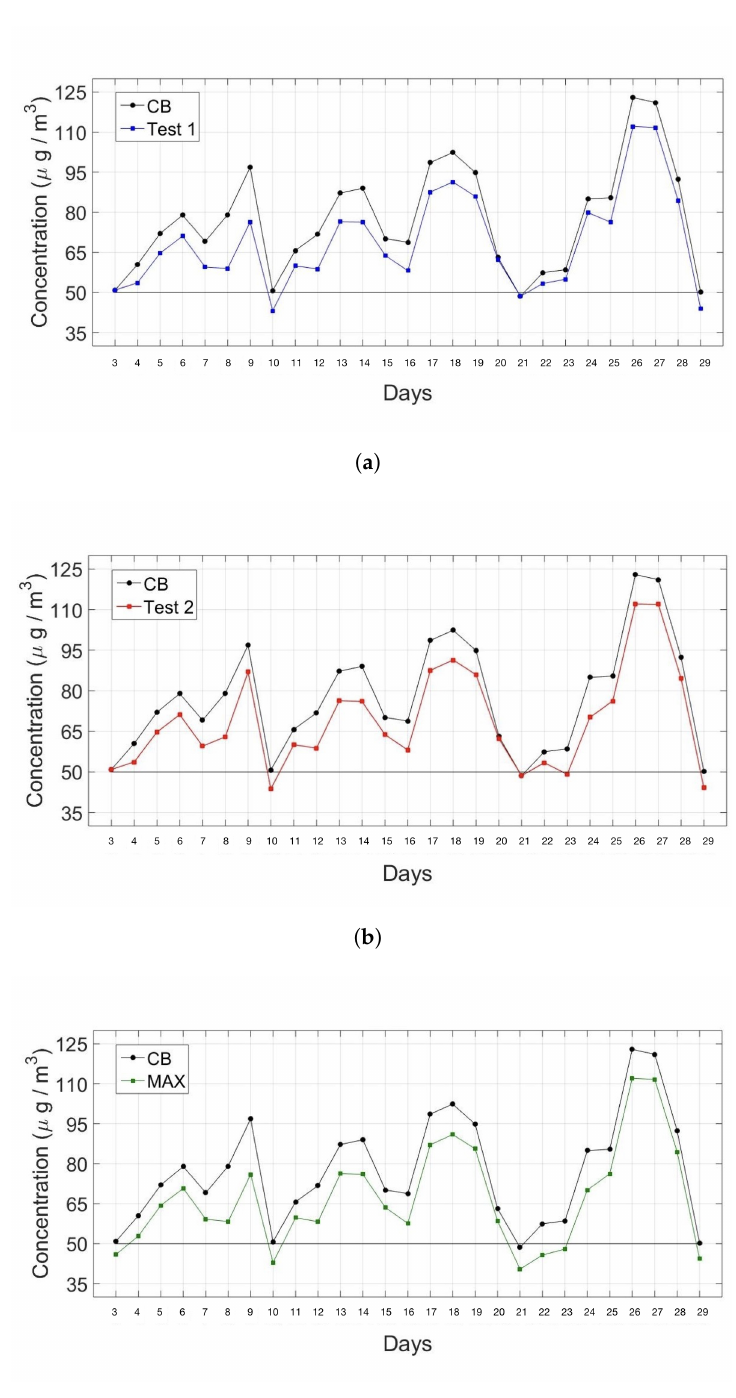
Figure 6. Particulate matter (PM 10 ) concentration before (CB) and after the actions for Test 1 ( a ), Test 2 ( b ) and Test Max ( c